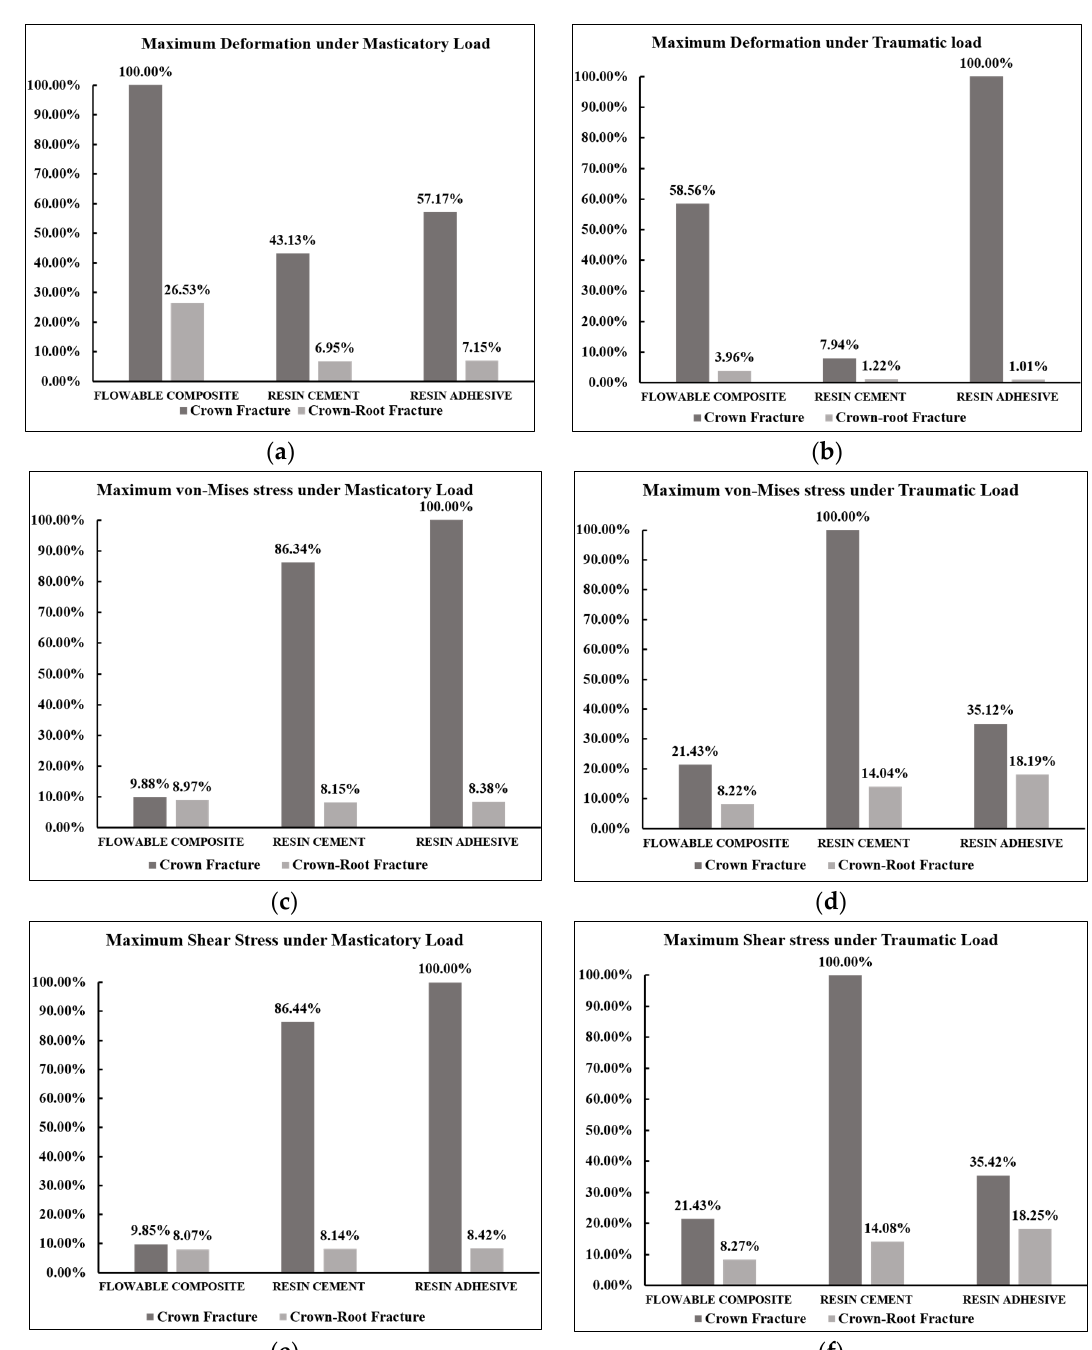
Figure 11. Effect of adhesive materials and varying loads on the reattached tooth. Maximum displacement under ( a ) masticatory load ( b ) traumatic load, von Mises stress under ( c ) masticatory load, ( d ) traumatic load, shear stress across ( e ) masticatory load, ( f ) traumatic load across both crown fracture and crown–root fracture.